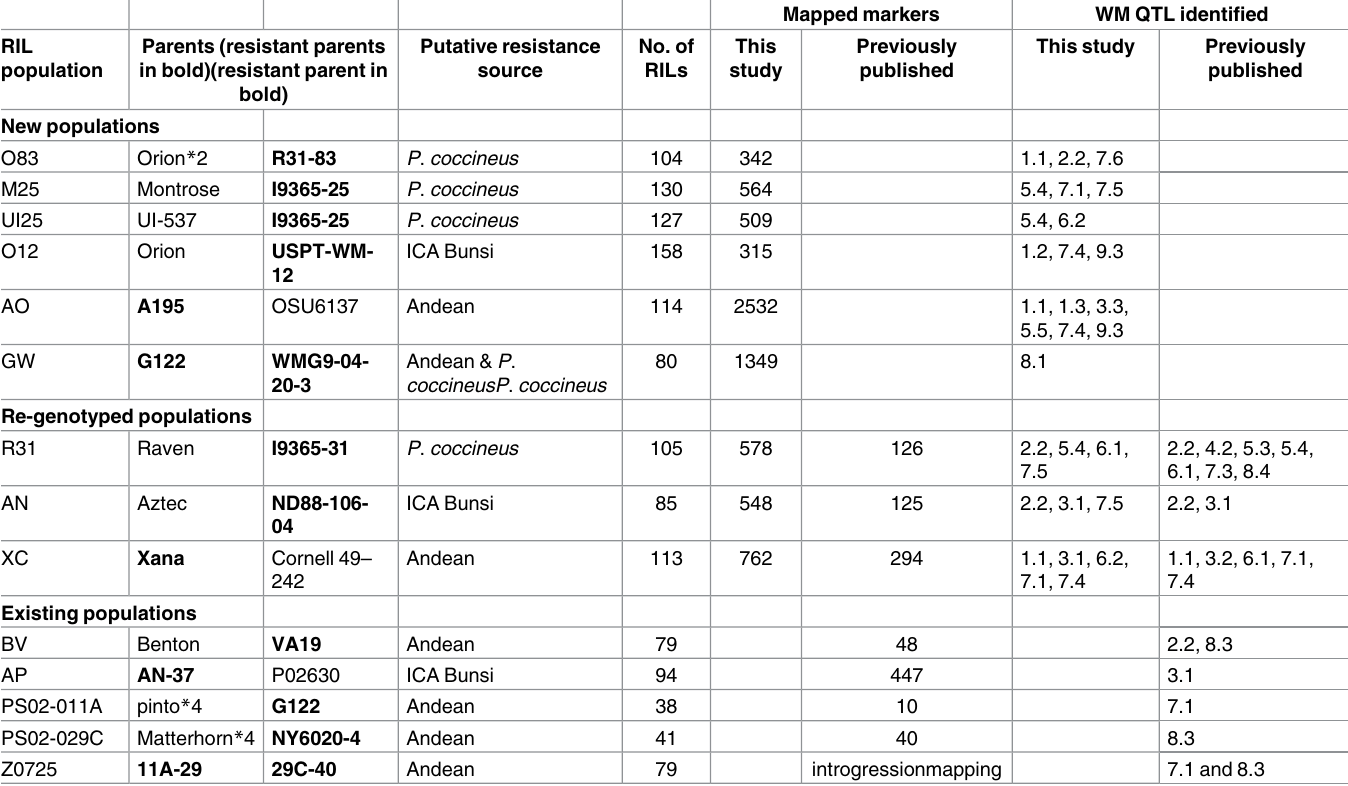
Table 1. Characterization of 14 RIL populations used for meta QTL analysis for white mold resistance in common bean.